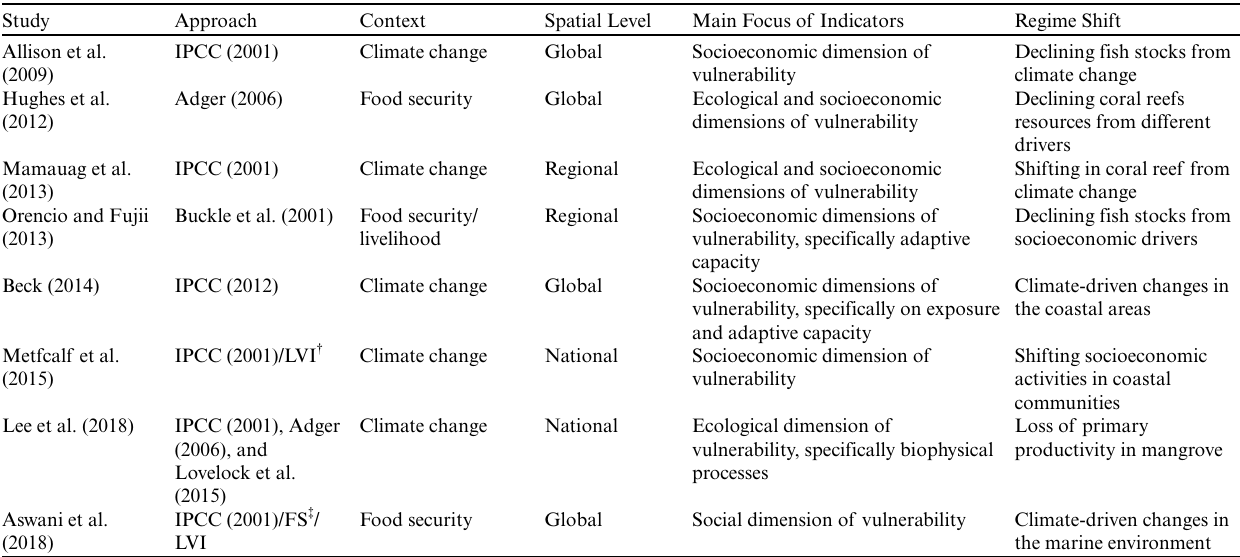
Table 1 . Comparison of different approaches used in marine hot spot countries. Information regarding the framework used, indicators, spatial scale, geographic area, and other determinants in the vulnerability assessments. FS, food security; IPCC, Intergovernmental Panel on Climate Change; LVI, Livelihood Vulnerability